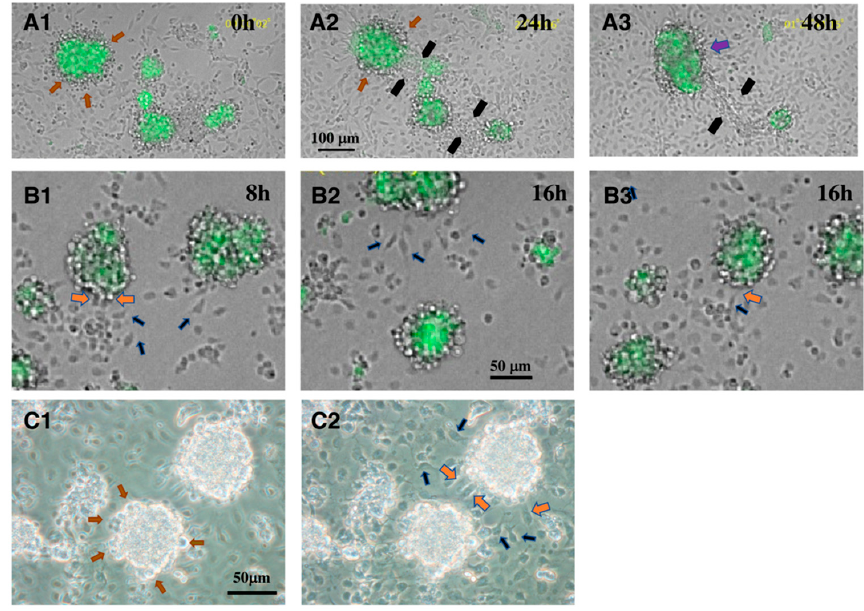
Figure 1. Live cell imaging shows direct interaction between CD34 + cells (telocytes) and ALCs in culture. (modified from Figure 4 and Supplementary Figure S3 in Abe et al. [41]). ( A1 – A3 , B1 – B3 ) Merged figures of GFP (ALCs) and bright-field (CD34 + cells) images are shown. All photographs shown here are slice snapshots. ( A1 – A3 ) An example showing that two re-aggregates, each consist- ing of LCs (inside) and CD34 + cells (outside) are connected by cytoplasmic processes extending from CD34 + cells on each re-aggregate (black arrows in ( A2 , A3 )) and coalesced into one re-aggregate (pur- ple arrow in ( A3 )). Orange arrows in ( A1 , A2 ) show round CD34 + cells that attach around LC-re- aggregates. (modified from Figure 4C1–C3 [41]). ( B1 – B3 ) Behavior of CD34 + cells toward re-aggre- gates of LCs and CD34 + cells. Blue arrows in ( B1 , B2 ) show CD34 + cells that attach to the dish, extend filopodia (telopodes), and are approaching re-aggregates of LCs and CD34 + cells. Orange arrows in ( B1 , B3 ) show CD34 + cells that are just plunging into re-aggregates of LCs and CD34 + cells. (modified from Figure 4B2, B3 [41]) ( C1 , C2 ) Phase contrast microscopy shows re-aggregates of LCs and CD34 + cells, and CD34 + cells that attach to the dish. ( C1 ) Focus is on some round CD34 + cells (orange ar- rows) that attach around LC re-aggregates. ( C2 ) Focus is on CD34 + cells that attach to the dish. Blue arrows indicate CD34 + cells that are approaching re-aggregates of LCs and CD34 + cells by extending thin filopodia (telopodes). Orange arrows show CD34 + cells that are just plunging into re-aggregates of LCs and CD34 + cells. (modified from Supplementary Figure S3 [41]). 4. Roles of CD34 + Mesenchymal Cells as a Constituent of Stem Cell Niche and/or Stem/Progenitor Cells In general, CD34 + mesenchymal/stromal cells are considered to play crucial roles in tissue renewal and regeneration as a constituent of a stem cell niche in various organs such as intestine, skeletal muscle, heart, lung, and skin [24,45–52]. Two functions of CD34 + mesenchymal cells in various stem cell niches are reported; one is in support of the pro- liferation of stem cells and their differentiation during regeneration, and the other is as progenitors of differentiated cells in the regeneration in response to inflammation. For example, during the repair of the enteric wall, tissue-resident human CD34 + mesenchymal cells play a role as a source of α -smooth muscle actin + myofibroblasts [52]. As mentioned in an earlier section, two types of LCs, FLCs and ALCs, develop in the fetal and postnatal testes, respectively. A model of two pathways of FLC differentiation has been proposed [15,53]. The first pathway is that progenitors are derived from the coelomic epithelium, and differentiate into FLCs directly; the second one is that progenitors are derived from Nestin-positive perivascular cells that co-migrate with endothelial cells from the